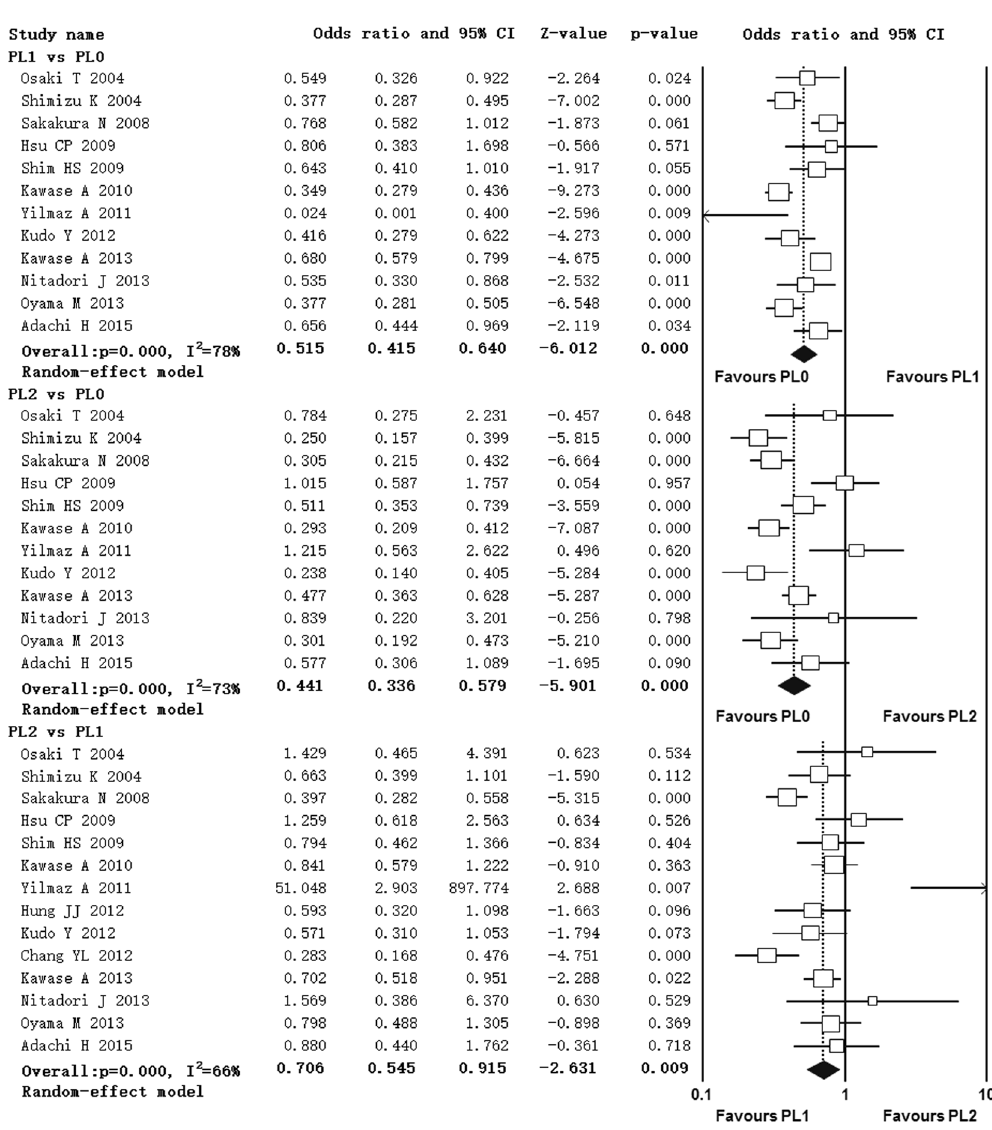
Figure 3. Forest plot showing the impact of extent of VPI on 5-year survival rate. * CI: confidence interval, PTNB: percutaneous transthoracic needle biopsy.